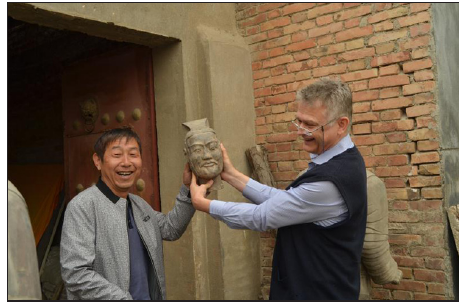
Figure 3: Director Hou of the Emperor